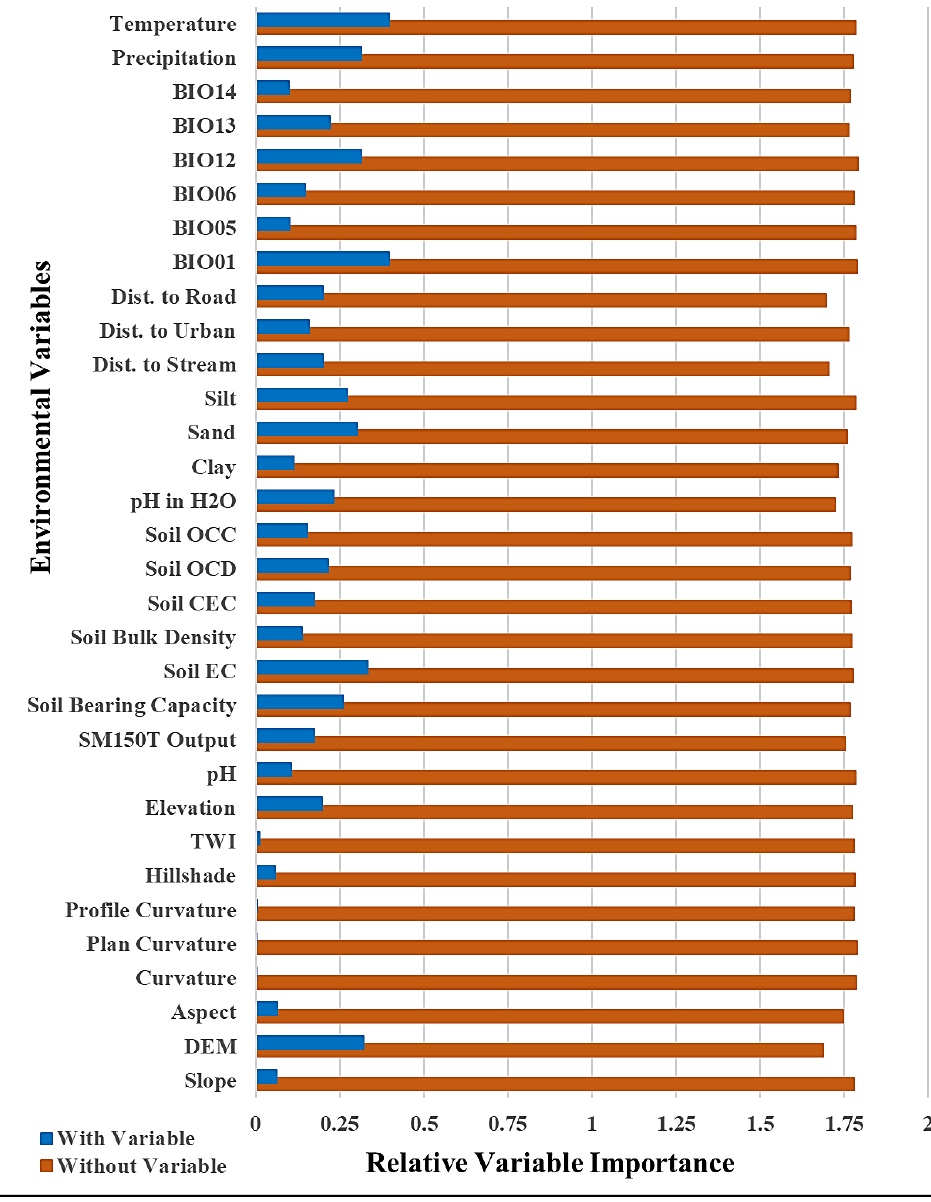
Figure 3. Analysis of relative importance of effective environmental variables.